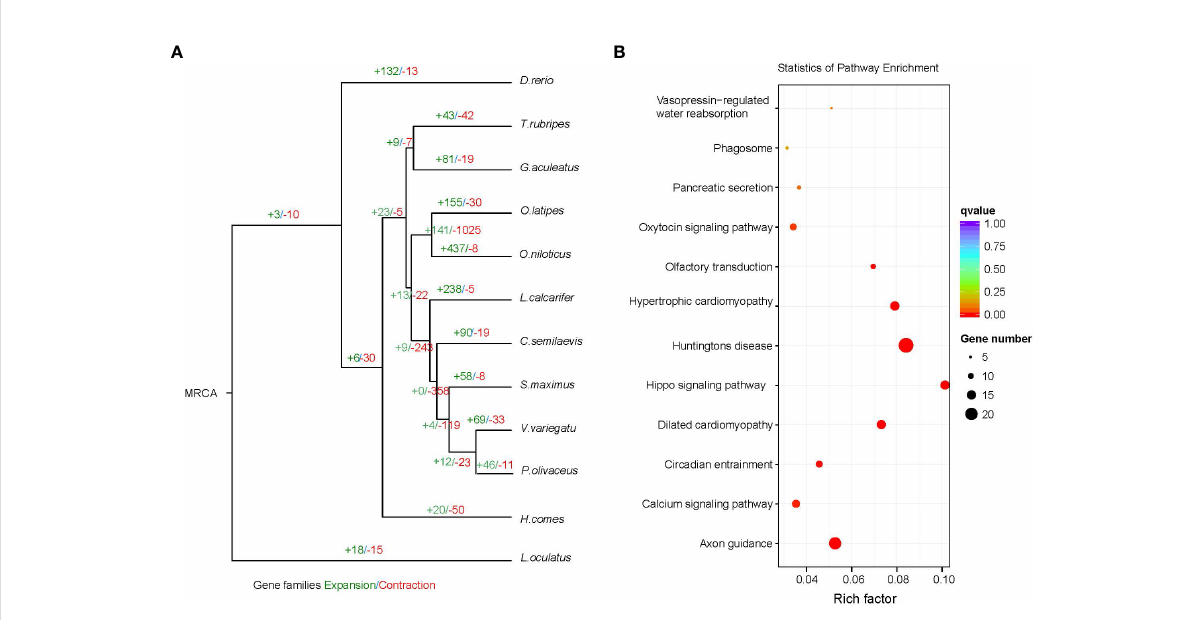
FIGURE 4 Gene family comparison. (A) Gene family size change analysis, including the number of expanded gene families (+) and contracted gene families (-). (B) KEGG enrichment analysis of expanded gene